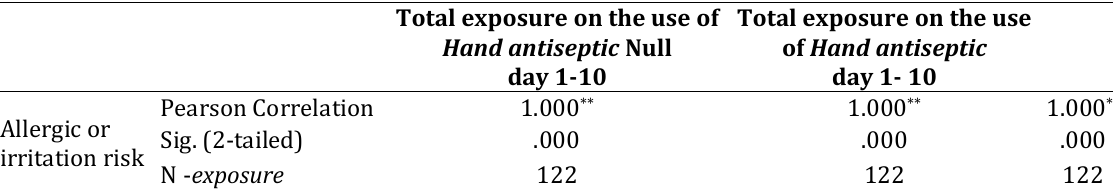
Table X. Test data for the significance of irritation/allergic risk vs. number of exposure on the use of hand antiseptic